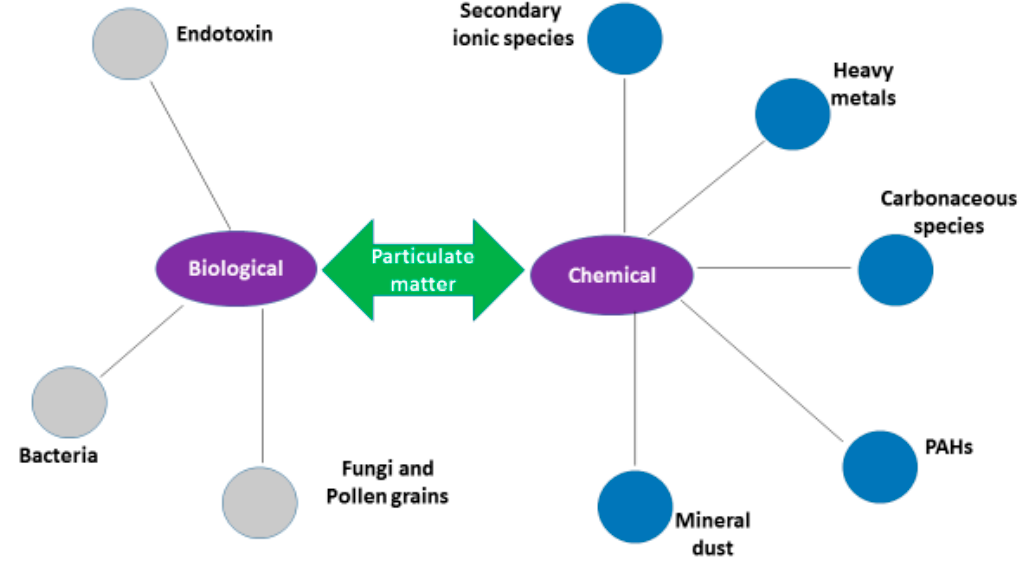
Figure 1. Biological and chemical components of particulate matter.